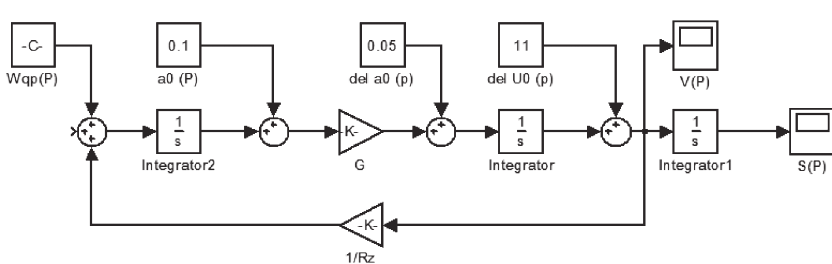
Fig. 1. Model of the error in one channel of an inertial